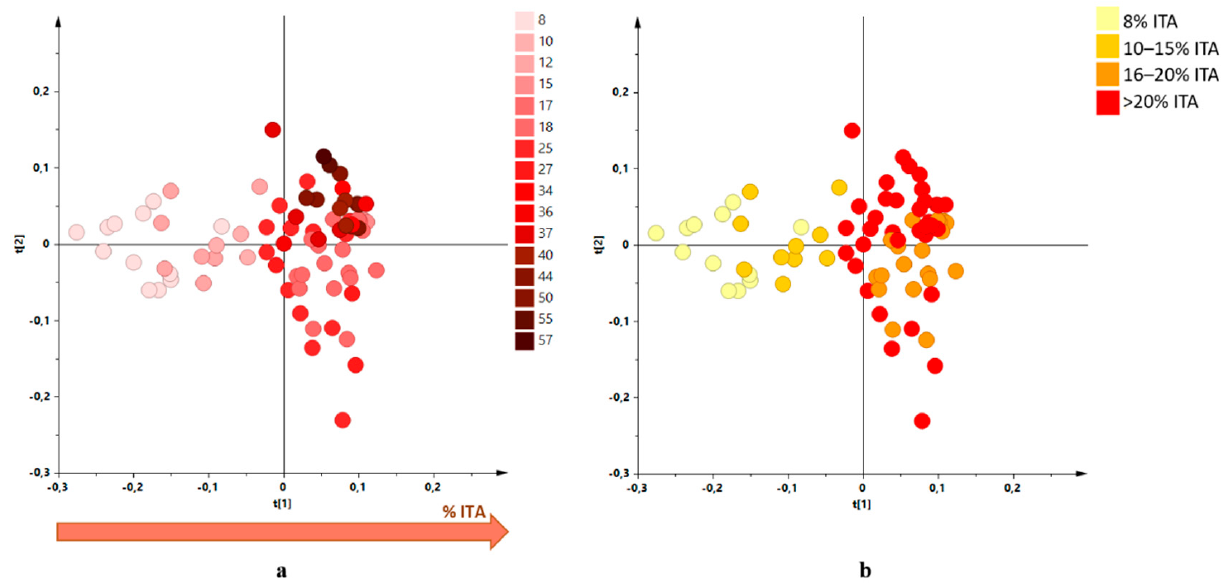
Figure 2. ( a ) Score plot of the Figure 1 PCA model showing the samples colour coding according to the increased percentages of Italian oil. ( b ) Score plot of the Figure 1 PCA model simplified to four classes colour coding: 8%, 10–15%, 16–20%, >20%.